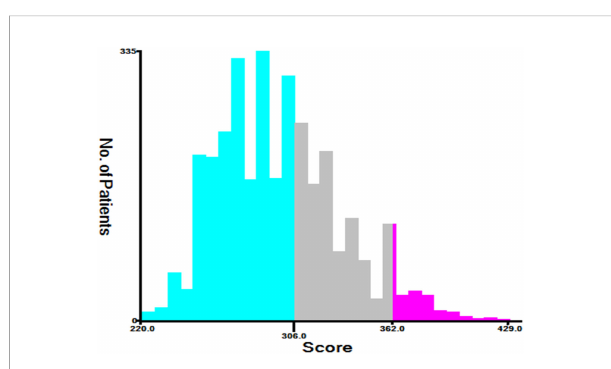
FIGURE 7 The optimal cut-off for the total scores gained by X-Tile. The total risk scores for most patients in this study ranged from 220 to 400 (low risk: 220 ≤ total score < 306, medium risk: 306 ≤ total score < 362, and high risk: 362 ≤ total